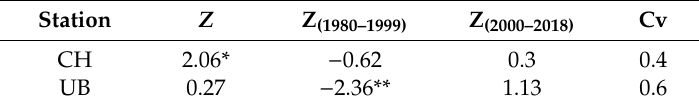
Figure 4. Variations of annual runoff and rainfall at CHUMPHON (CH) ( a ) and UBON (UB) ( b ) stations.